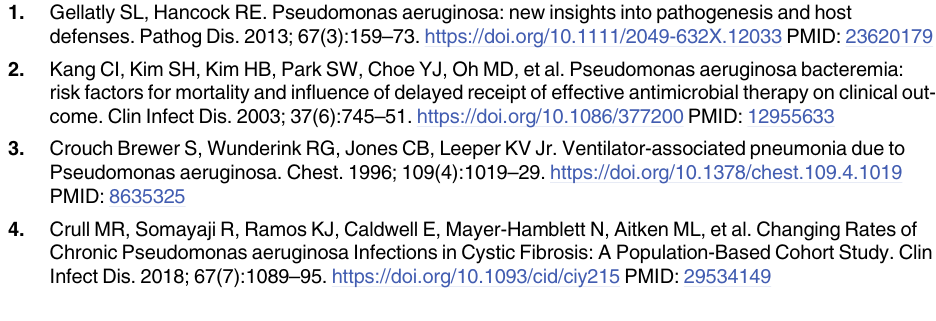
S6 Fig. WT and GrzmB&H KO YT cell viability is not altered following co-culture with P . aeruginosa . WT or GrzmB&H KO YT cells co-cultured with P . aeruginosa PAO1 for 6 h. After co-culture, the YT cell viability was assessed using trypan blue staining. Conditions were carried out in n = 4 wells (mean ± SEM) and the graph is representative of n = 1 biological rep-